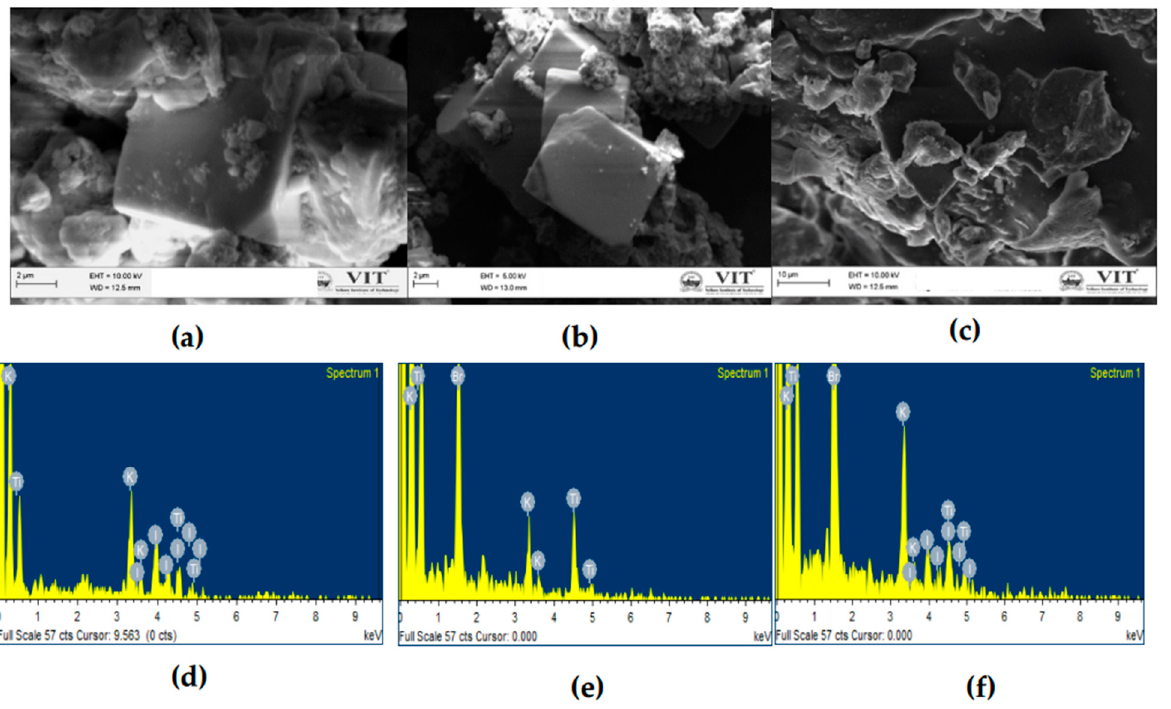
Figure 2. SEM images of ( a ) K 2 TiI 6 ; ( b ) SEM of K 2 TiBr 6 ; ( c ) SEM image of K 2 TiI 2 Br 4 . ( d ) EDX spectrum of K 2 TiI 6 ( e ) EDX spectrum of K 2 TiBr 6 ( f ) EDX spectrum of K 2 TiI 2 Br 4 .